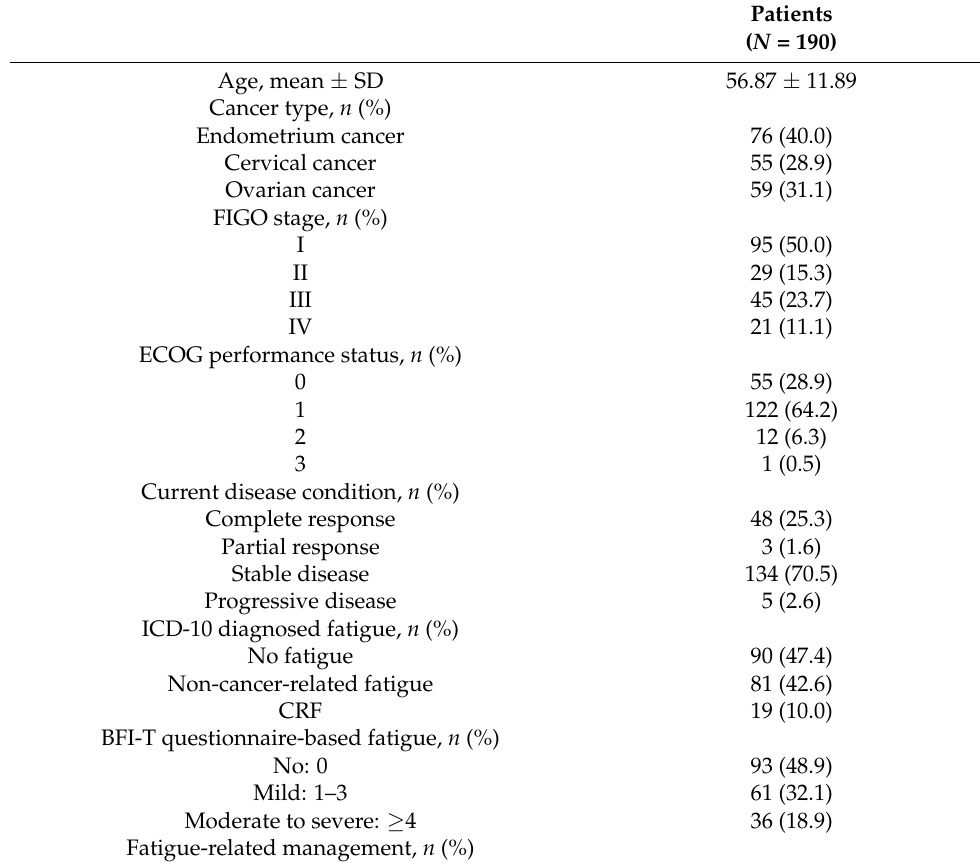
Table 1. Demographic characteristics of the enrolled